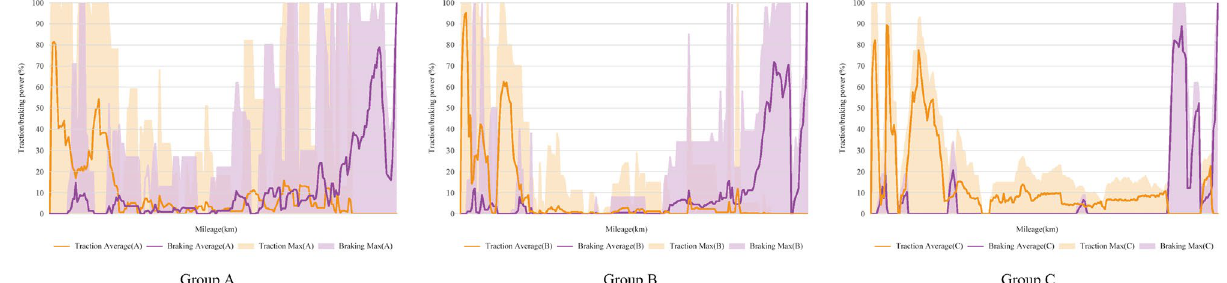
Figure 3. Driving operations of the three groups. The operating differences between participants were considerable. However, the difference between the groups could not be clearly shown using the average ± standard deviation, so the average value and the maximum value were used to present the traction and braking power. The minimum value was 0, which is not shown in the figure.